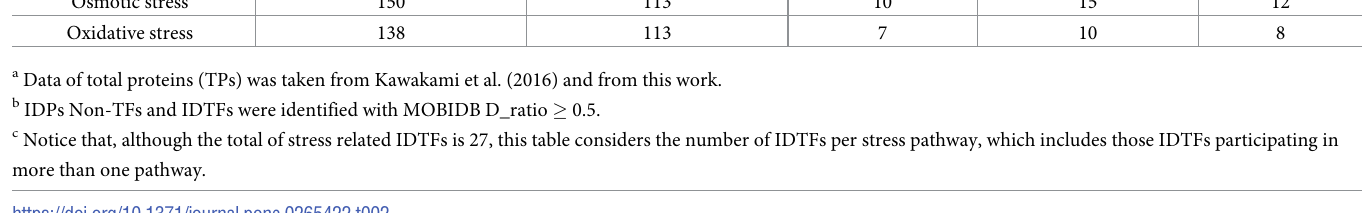
IDPs in the osmotic stress pathway, 30 in the signaling cascade leading to the nutrient limita- tion response, and 18 and 14 in the oxidative stress and heat stress signaling pathways, respec- tively. As expected, these numbers increase if we use VSL2-PONDR for this analysis (Fig 3).